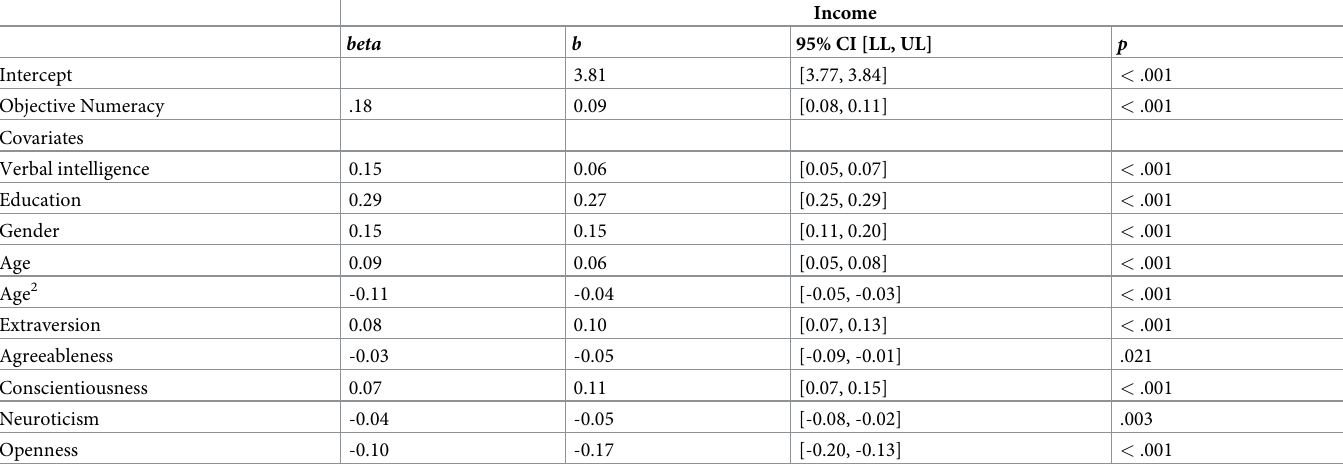
Table 2. Linear regression analysis results of income predicted from objective numeracy, verbal intelligence, education, gender, age, age 2 , and Big-Five personality factors.